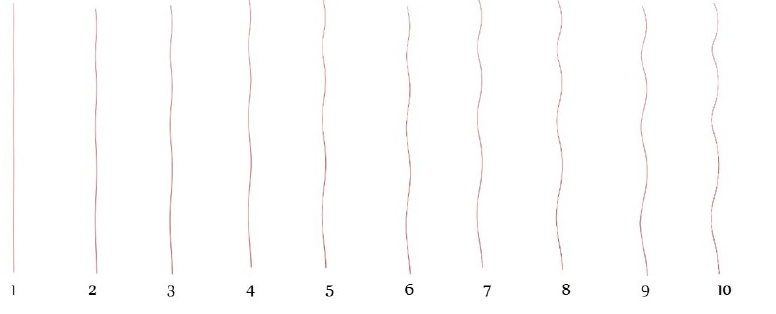
Figure 14. Arrangement of fibres in different layers of the